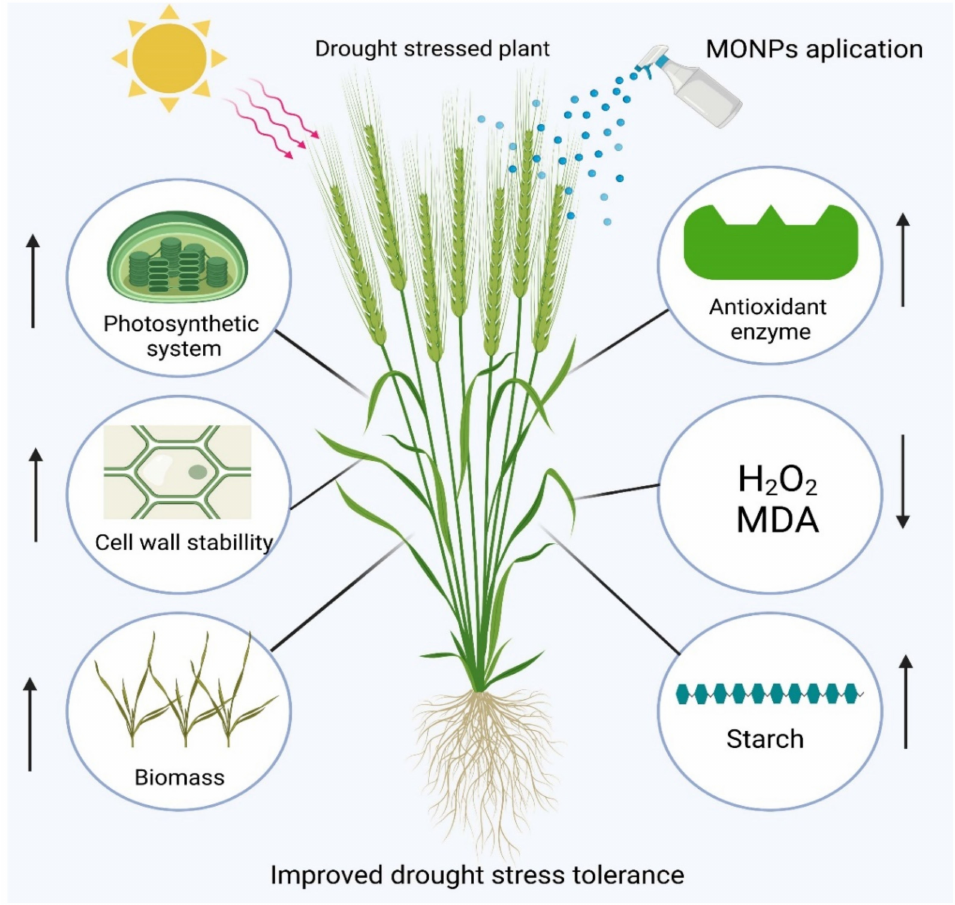
Figure 2. Metal oxide nanoparticles (MONPs) induced drought stress tolerance in plants through a general mechanism. Created with